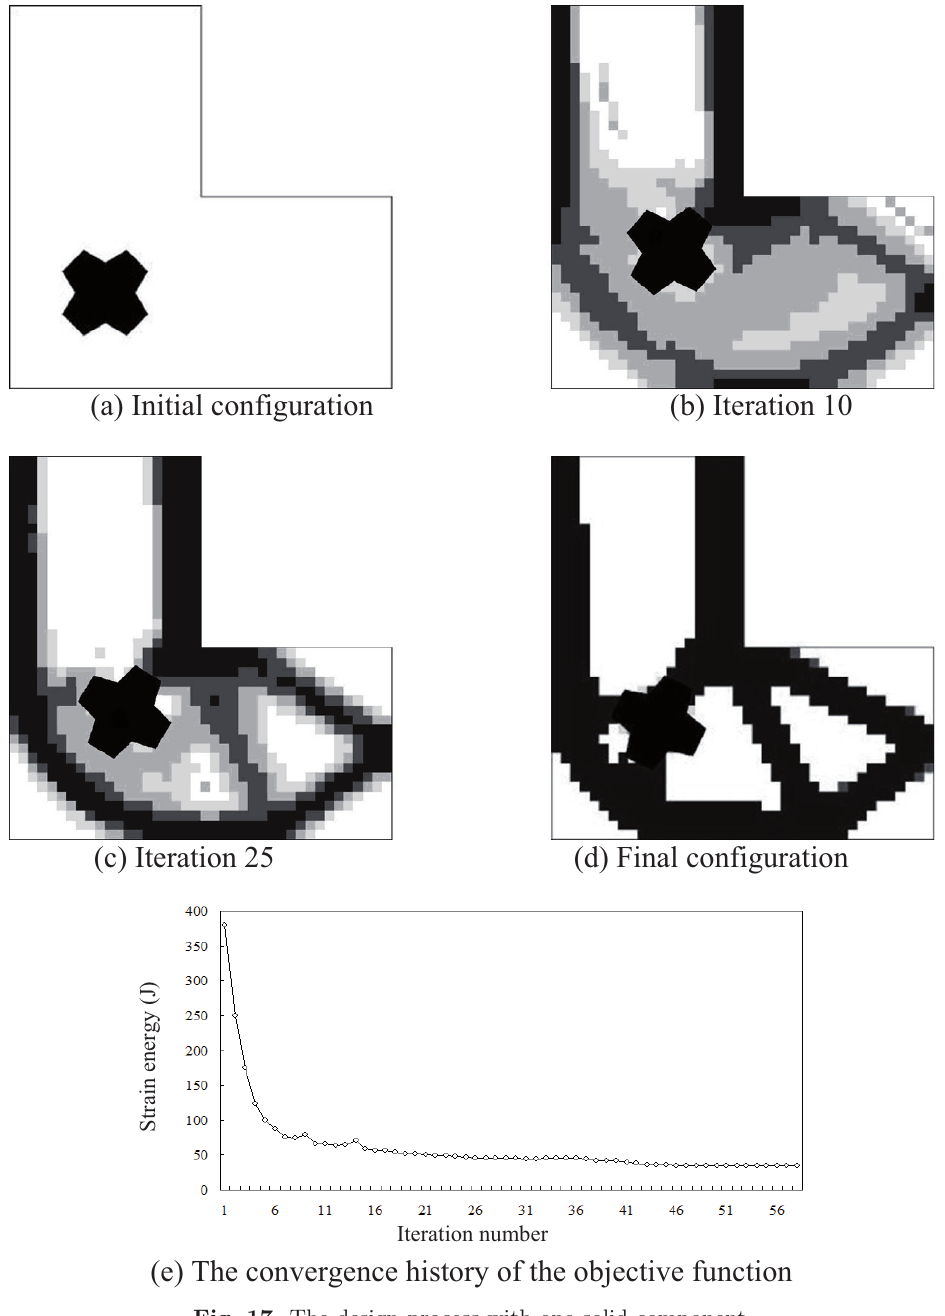
Fig. 17. The design process with one solid